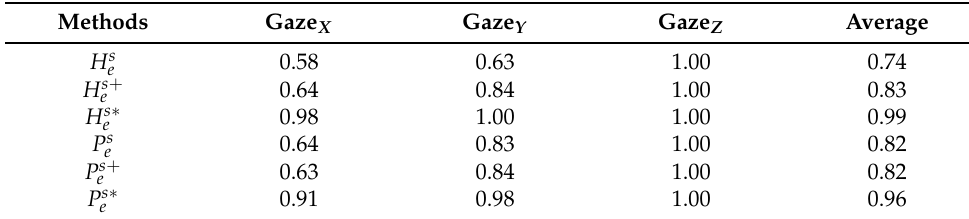
Table 1. The Gaussian PDF of simulated gaze estimations between − 0.5 ◦ and 0.5 ◦ .